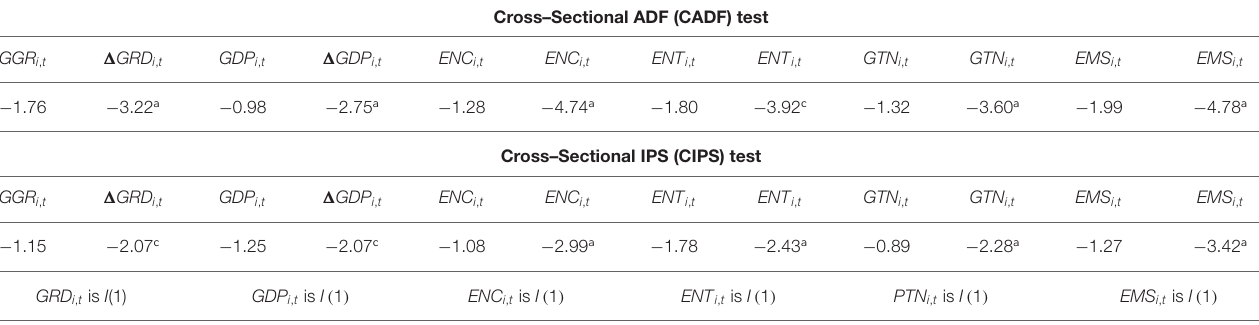
TABLE 5 | Second generation unit root tests for individual variables.